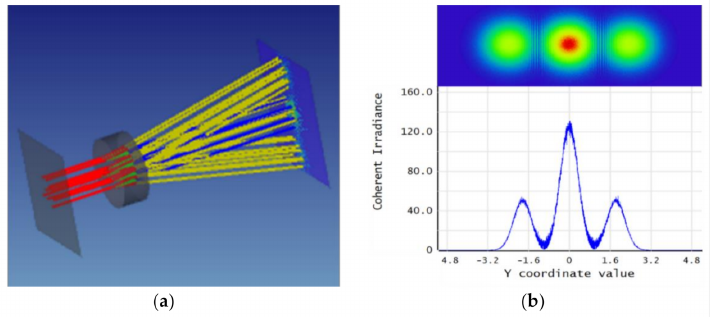
Figure 5. ( a ) Light path simulation with microcavity interference. ( b )The simulation figure of micro light intensity diffraction pattern with a 0, +1, and − 1 level. The Y -axis is along the direction in which the diffraction orders separate.